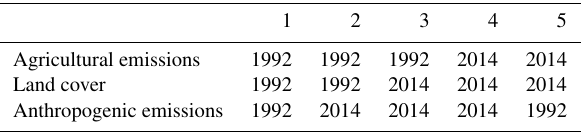
Table 1. Model configurations. The numbers in the top row are re- ferred to in the main text. 1 2 3 4